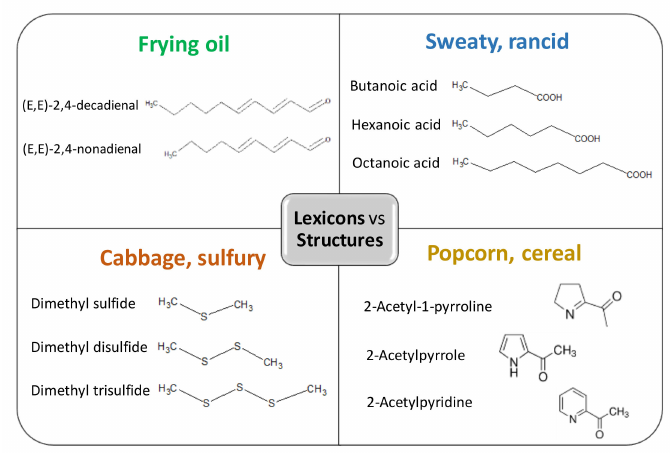
Figure 1. Chemical structures of o ff -aroma compounds grouped by sensory